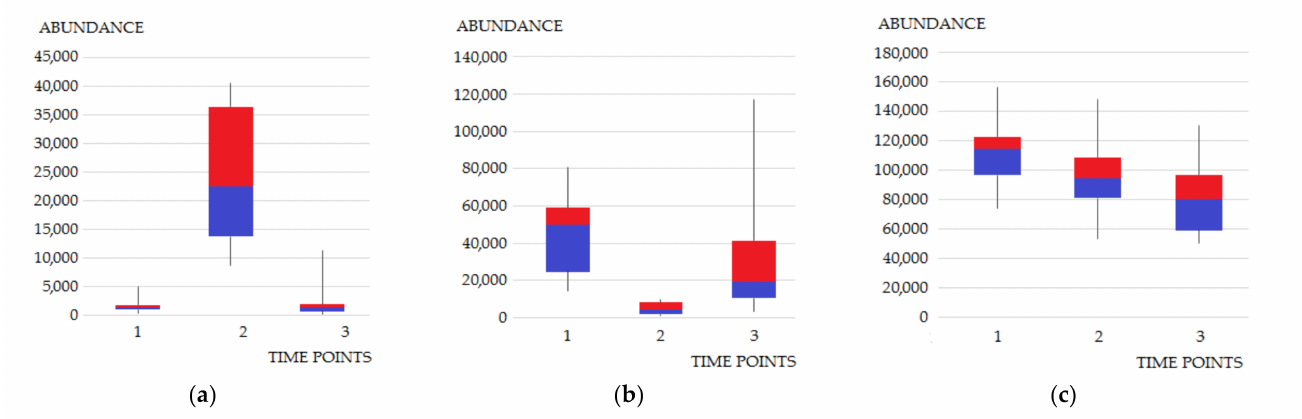
Figure 3. Differences in metabolite abundance at three time points for ( a ) propanoic acid, ( b ) meso- erythritol, ( c ) uridine. Signal intensities were normalized by SG. p -values, indicating the statistical significance of the differences in abundance between time points “1” and “3”, for propanoic acid, meso-erythritol and uridine were 0.52, 0.22 and 0.02, respectively. Legend: Line segments, blue and red boxes represent consecutive quartiles. Time points: “1”—samples collected before TURBT; “2”—samples collected the day after TURBT; “3”—samples collected at follow-up visit (14 days after TURBT). The number of samples: “1” = 10, “2” = 10, “3” = 10.